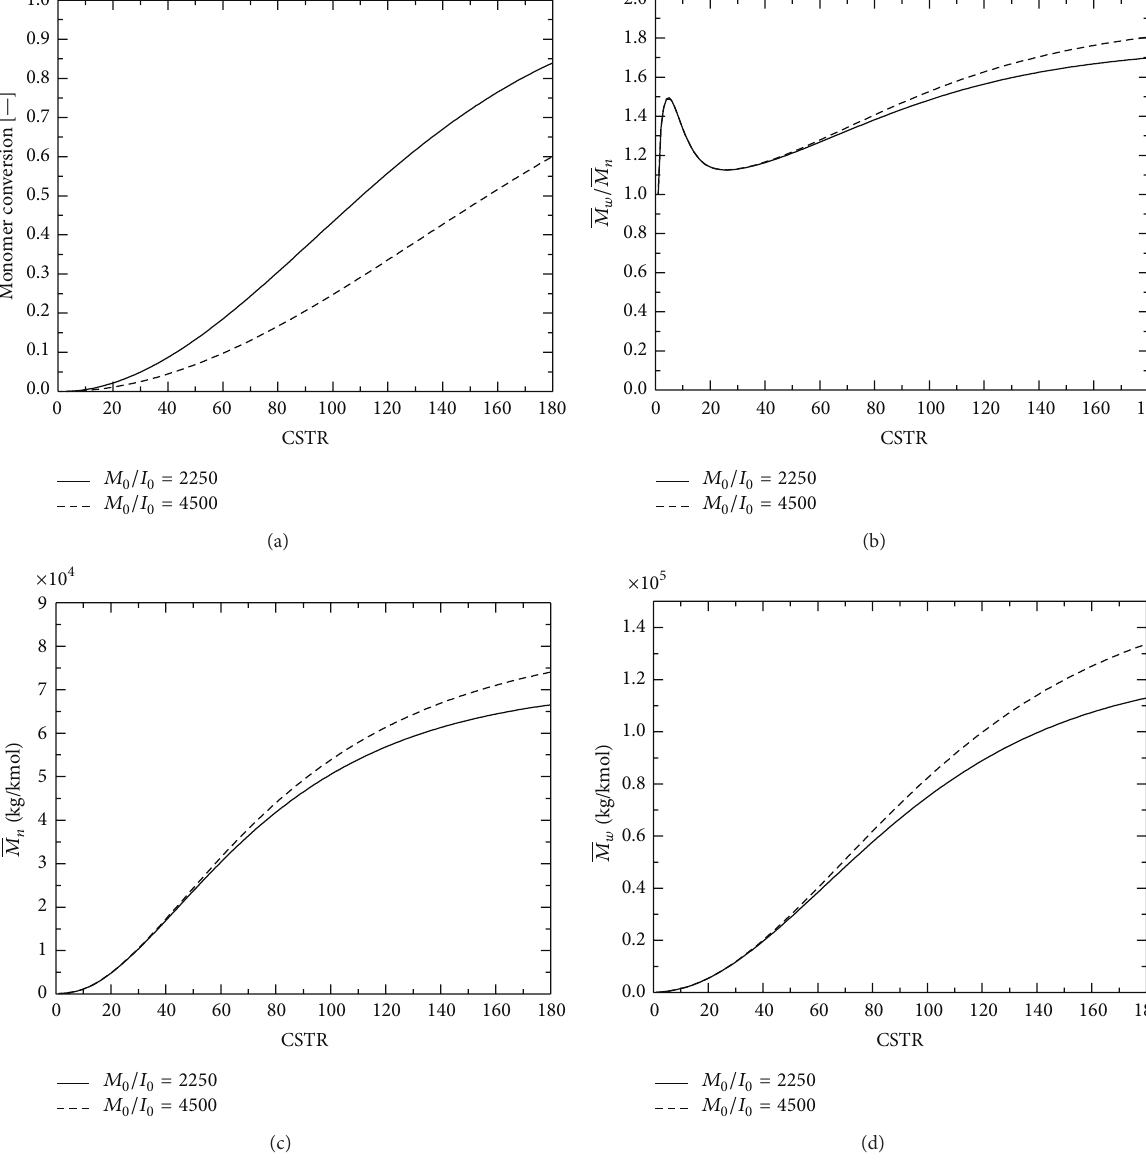
Figure 4: Effect of the monomer to initiator ratio 𝑀 0 /𝐼 0 on (a) the monomer conversion, (b) polydispersity index, (c) the weight average molecular number 𝑀 𝑛 , and (d) the weight average molecular weight 𝑀 𝑤 along the extruder chambers, at 𝑇 = 190 ∘ C and rpm =